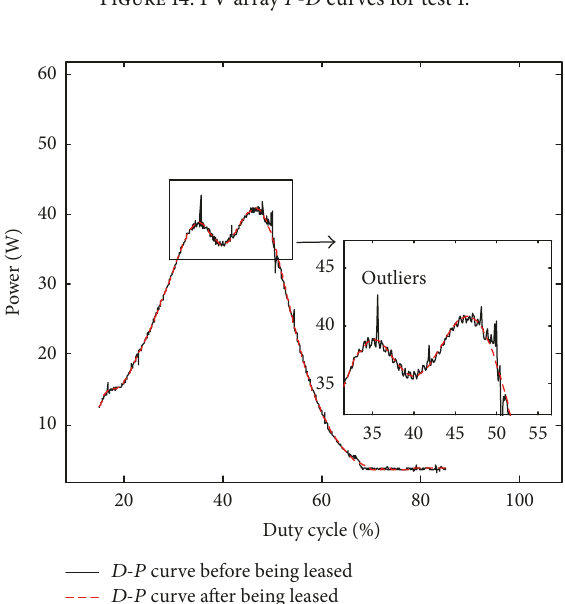
Figure 14: PV array P - D curves for test 1.